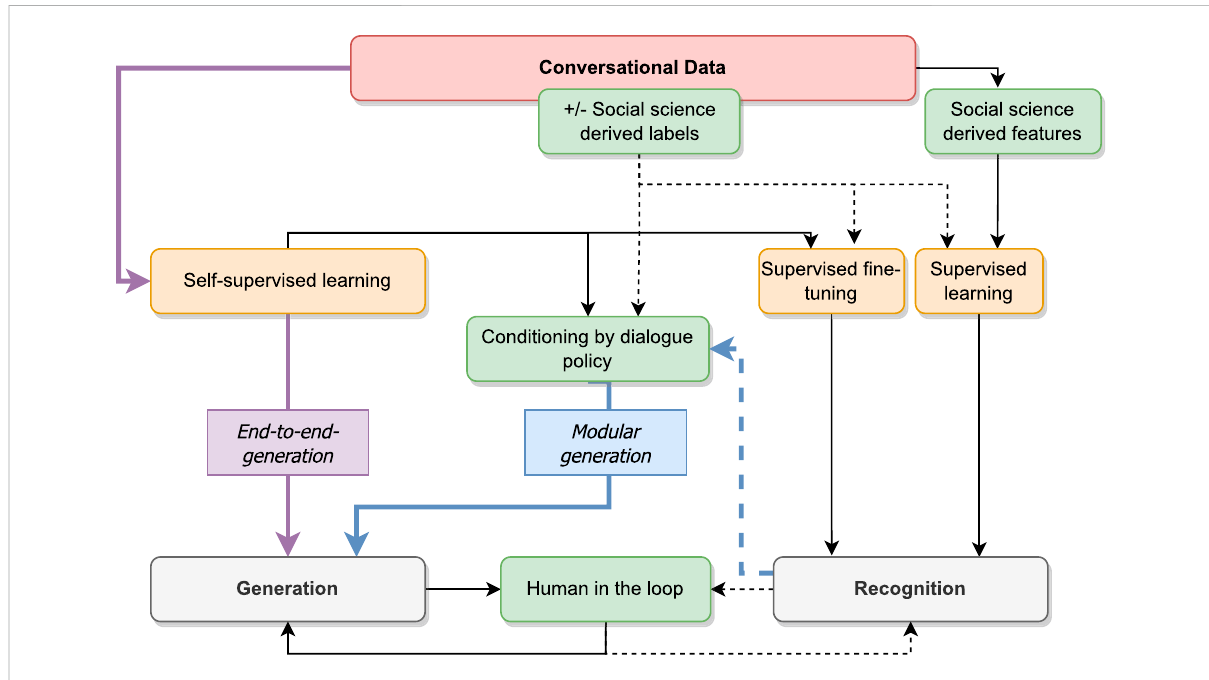
FIGURE 3 Machine learning approaches in socio-conversational systems. Orange boxes represent the different types of supervision of machine learning models, white boxes the different usages, green boxes the intervention of external knowledge, and blue and purple arrows represent the modular and end-to-end settings, respectively. Dotted arrows indicate when the information comes from labels derived from human